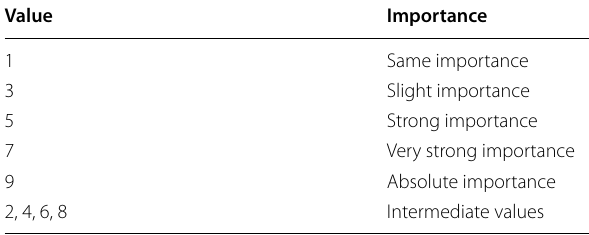
Table 3 Saaty’s scale of relative